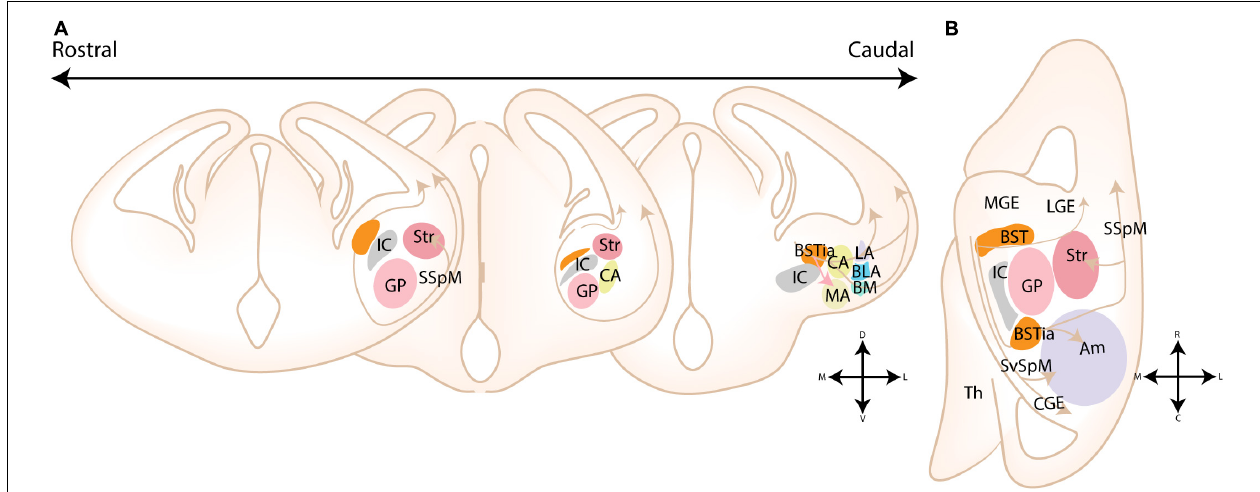
FIGURE 8 | Migratory routes of cells originating in the Diagonal area. (A) Rostrocaudal gradient of schematic coronal sections showing the migratory routes of caudoventral MGE/Diagonal area (cvMGE/Dg)-derived cells toward the cortex, striatum and amygdala. At rostral levels, the early-born Dg-derived cells selectively surround the Globus Pallidus (GP), after which cells migrate subventricularly (smaller population, smaller arrow) or superficially toward the striatum and cortex. At more caudal ends of the telencephalon, a presumed radially migrating stream of Sst cells originating in the intraamygdaloid part of the BST (BSTia) passes behind the GP, through the developing CA, thereby connecting to the SSpM laterally. An intraamygdaloid migratory stream tangentially colonizes the pallial amygdala starting from the BSTM(ia), passing the BLA dorsally and caudally, connecting rostrally and dorsolaterally with the LA and caudoventrally with the BMA. A continued migration connects this stream to the AHi (not shown). A migration route from the bed nucleus of the stria terminalis (BST) toward the medial amygdala (MA) is also shown (pink arrow), although this migration route is still controversial. (B) Schematic horizontal section showing the migratory routes of caudoventral MGE/Diagonal area (cvMGE/Dg)-derived cells toward the cortex, striatum and amygdala. The subpial subpallial migratory stream (SSpM) and the subventricular subpallial migratory stream (SvSpM) are marked. In addition to the routes mentioned in panel (A) , the AHi is also invaded, either from the SvSpM (shown) or medially from the intraamygdaloid stream (not shown). Str, Striatal domain; Pal, Pallidal domain; Dg, Diagonal Domain; POA, Preoptic Area; BSTL, lateral part of BST; BSTM, Medial part of BST; BSTia, intraamygdaloid part of BST; MA, medial amygdala; CA, Central amygdala; LA, Lateral amygdala; BLA, Basolateral amygdala; BM,